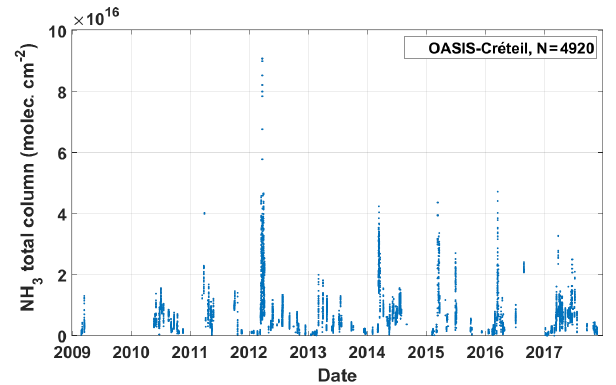
Figure 4. First multiyear time series of NH 3 total columns derived from OASIS measurements over Paris and retrieved from 4920 in- frared atmospheric transmission spectra measured during 234d be- tween 2009 and